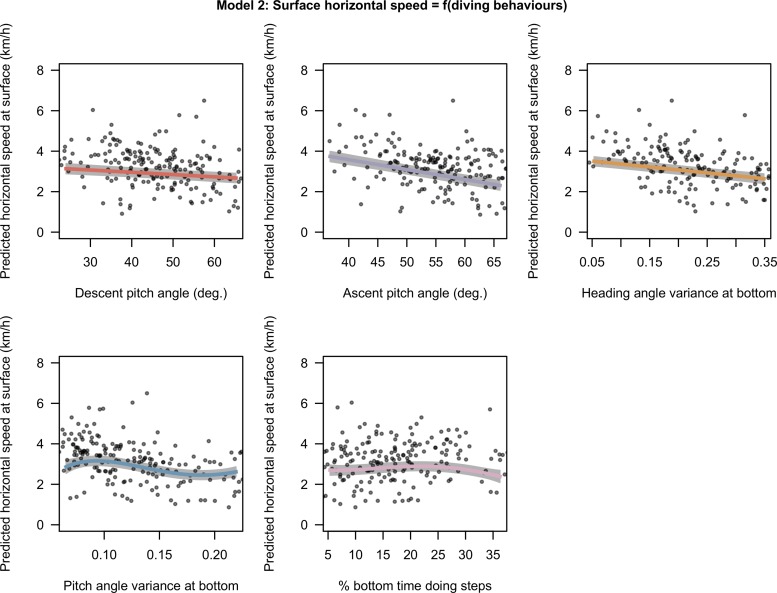
Estimated effects of covariates selected in model 2.The predictions for each covariate varying from the 5% to the 95% quantile of observed values with other covariates at their mean. The x axes have been scaled to range from -2 to 2 normalized so that regression slopes are comparable but are annotated with raw units so that units are comprehensible. The grey shades around the regression lines indicate the standard error of the mean prediction estimates.